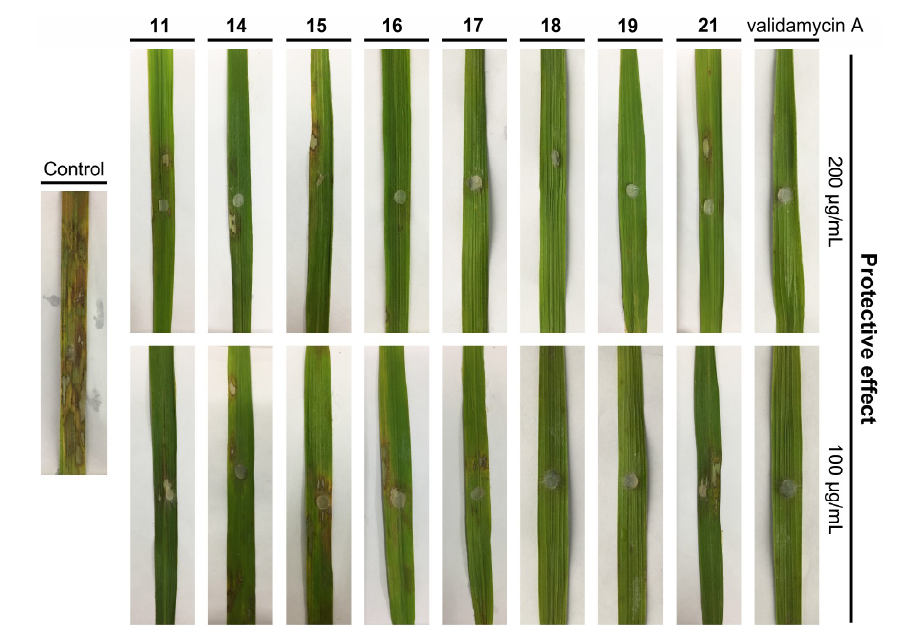
Figure 3. The in vivo protective effect of selected compounds against R. solani using detached leaf assay.